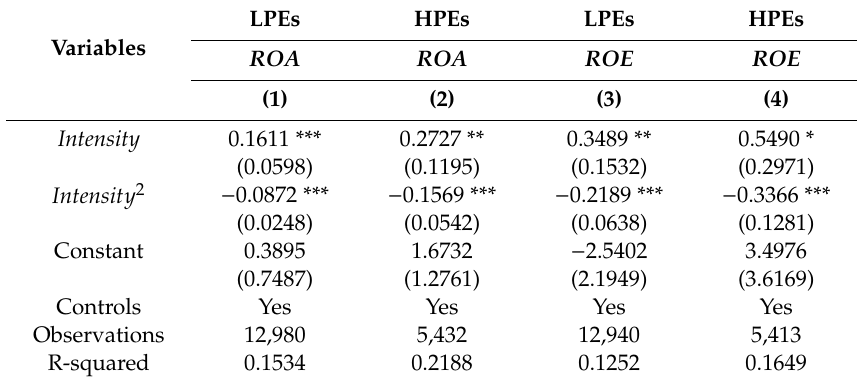
Table 6. The impact of ESI on the performance of HPEs and LPEs of